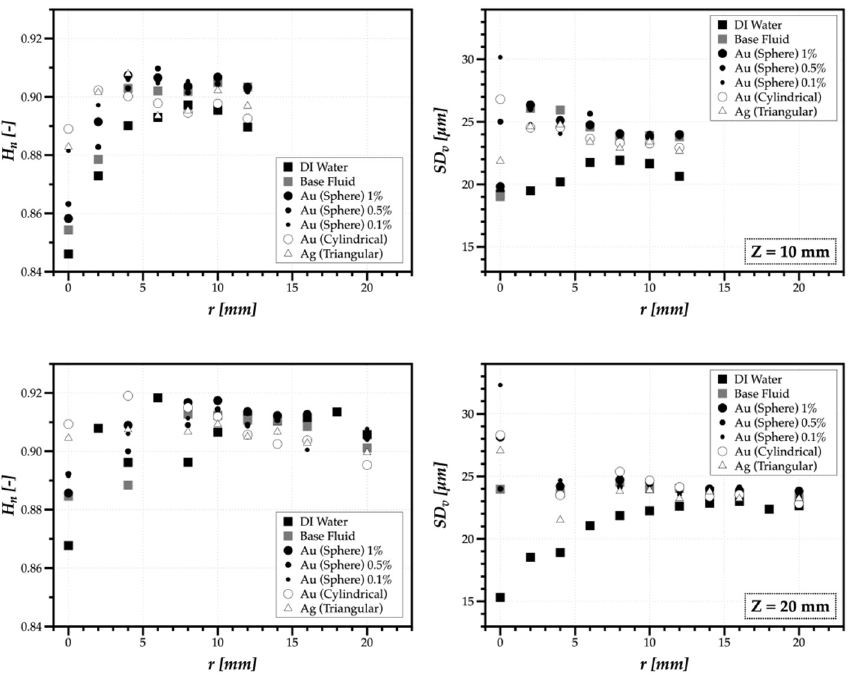
Figure 6. Polydispersion degree characterized by the normalized Shannon entropy, H n , and spray heterogeneity degree characterized by the volume-weighted standard deviation, SD v ( µ m), for the planes of Z = 10 mm ( top ) and Z = 20 mm ( bottom ).